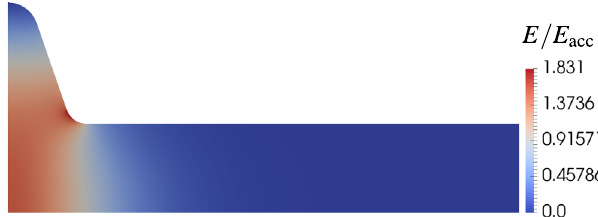
FIG. 10. The electric field of the FM in half of the chosen elliptical cavity, denoted FCC